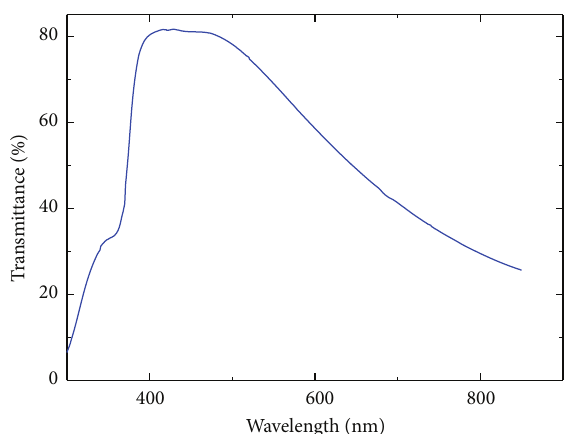
Figure 12: Dependence of the FOM of ZA(10)Z grown by different RF sputtering power on the PDA